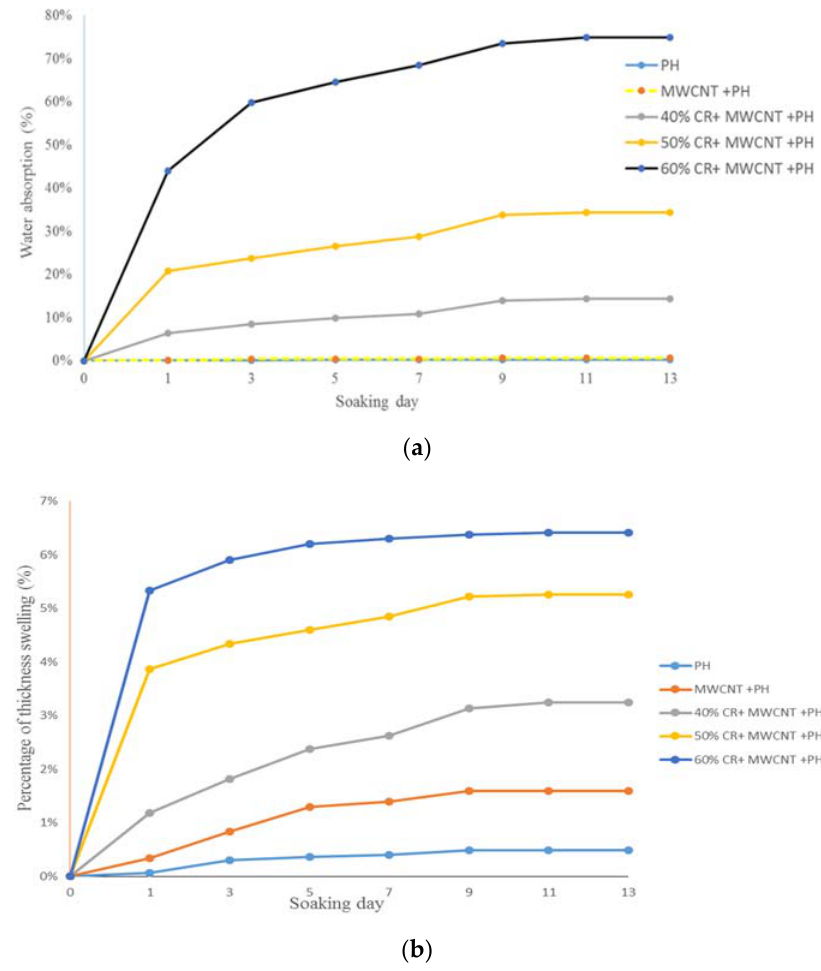
Figure 3. ( a ) Percentage of water absorption and ( b ) thickness swelling of CR reinforced MWCNT ‐ Phenolic composites.